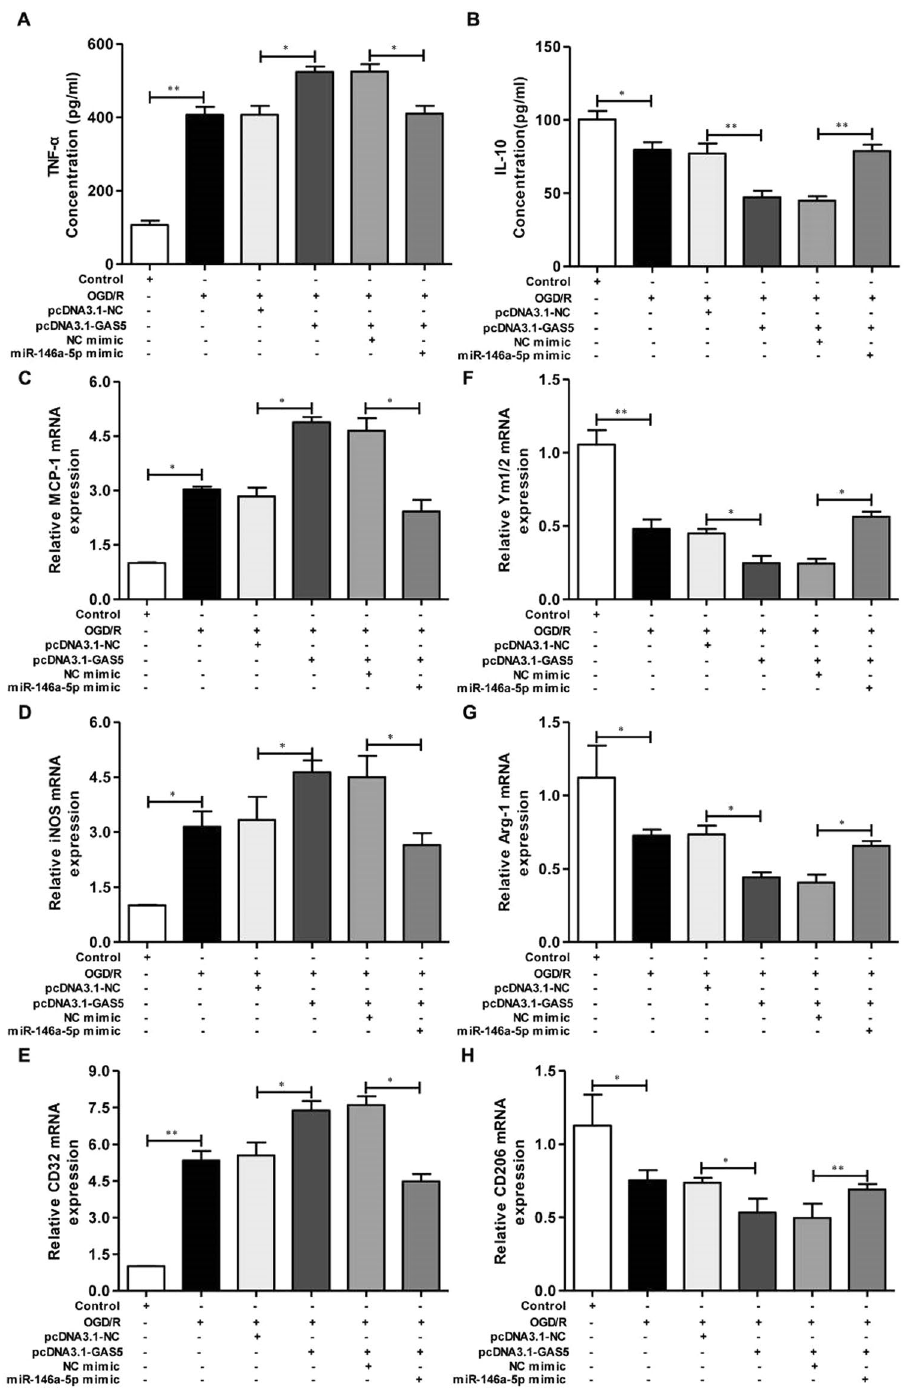
Figure 9. GAS5 affect OGD/R-induced macrophage polarization by miR-146a-5p in BV2 microglia cells. To investigate whether GAS5 could affect OGD/R-induced macrophage polarization by regulating miR-146a-5p. The BV2 microglia cells were transfected or co-transfected with pcDNA3.1-GAS5/pcDNA3.1-NC and miR- 146a-5p mimic/NC mimic. ( A , B ) The concentrations of TNF- α and IL-10 measured by ELISA. ( C – E ) RT-PCR detected the MCP-1, iNOS and CD32 mRNA expression levels. ( F – H ) RT-PCR detected the Ym1/2, Arg-1 and CD206 mRNA expression levels. Data are represented as mean ± SD, * P < 0.05, ** P <